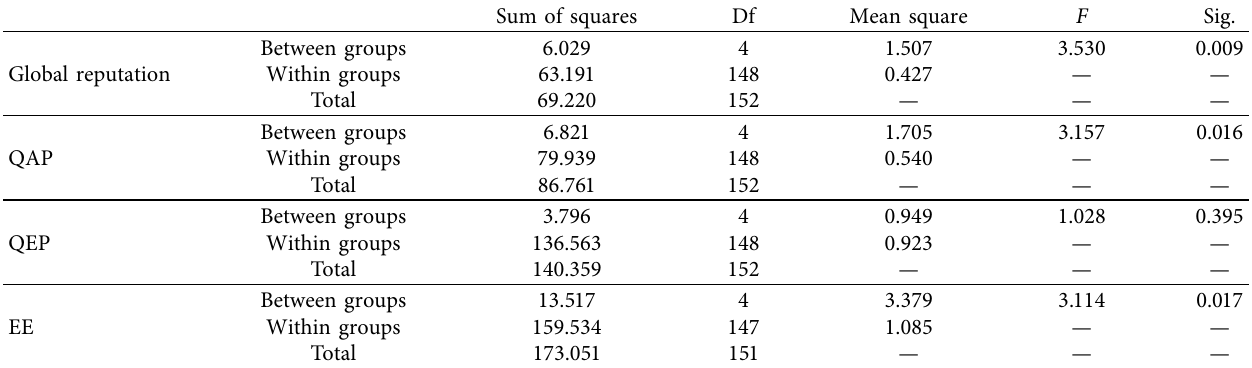
Table 5: ANOVA (age-based). Sum of squares Mean square Sig.